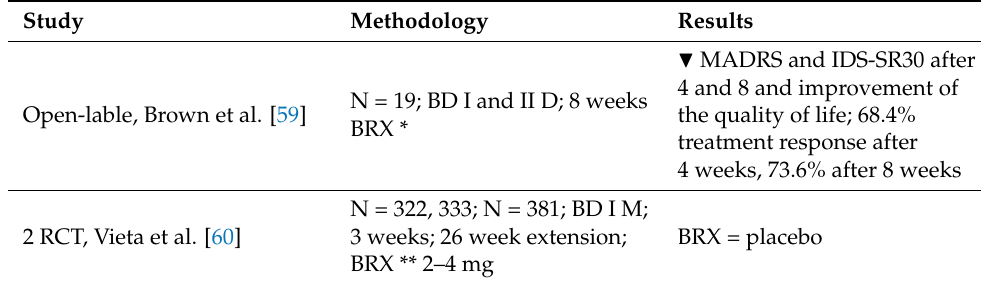
Table 5. The studies of brexpiprazole effectiveness in bipolar